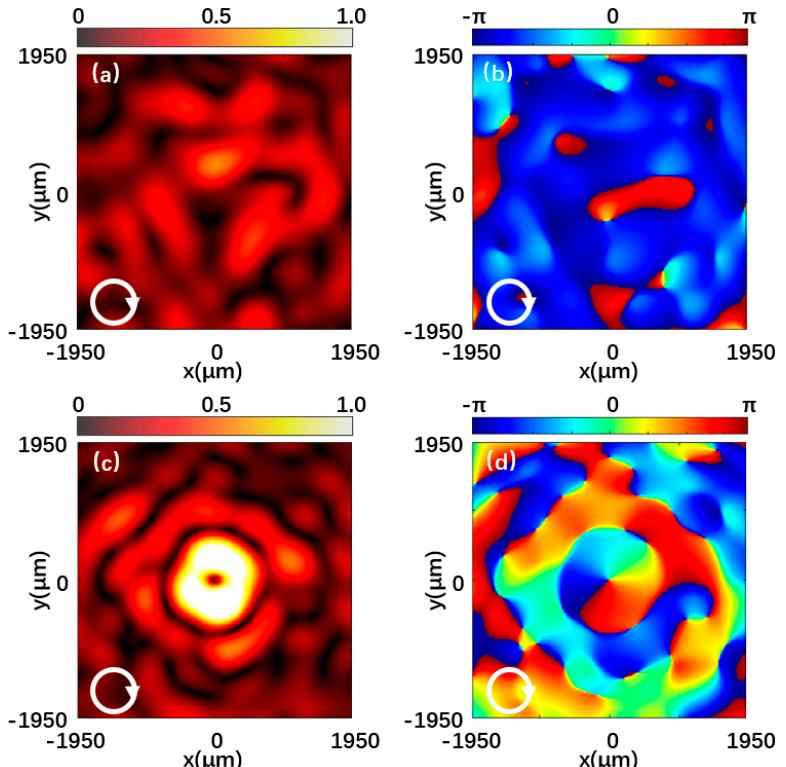
Figure 8. Reflected beam at 0.7 THz under the right-handed polarized light incidence. ( a , b ) Normalized intensity distribution and phase distribution of the left-handed component. ( c , d ) Normalized intensity distribution and phase distribution of the right-handed component.